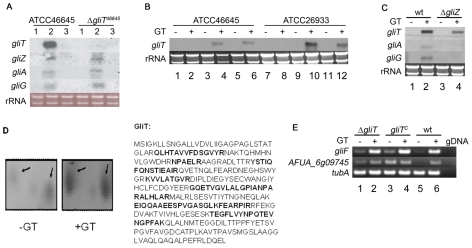

gliT expression.(A) Northern analysis of the induction of gliotoxin gene cluster expression in A. fumigatus ATCC46645 and ΔgliT. Lanes 1, 2 and 3 correspond to A. fumigatus RNA extracts from 21 h AMM, 21 h AMM shifted to gliotoxin (5 µg/ml) for 3 h and 24 h AMM, respectively. (B) Gliotoxin induction of gliT expression in A. fumigatus gliT
C strains. Lanes 1–6 and 7–12 contain RNA from strains in the ATCC46645 and ATCC26933 backgrounds, respectively. Lanes 1 and 7: A. fumigatus ΔgliT 24 h AMM; Lanes 2 and 8: A. fumigatus ΔgliT 21 h AMM+3 h gliotoxin (5 µg/ml); Lane 3 and 9: A. fumigatus gliT
C 24 h AMM; Lanes 4 and 10: A. fumigatus gliT
C 21 h AMM+3 h gliotoxin (5 µg/ml); Lanes 5 and 11: A. fumigatus wt 24 h AMM; Lane 6 and 12: A. fumigatus wt 21 h AMM+3 h gliotoxin (5 µg/ml). (C) Expression of gliT in ΔgliZ following exposure to gliotoxin. Cultures of A. fumigatus ATCC46645 (lanes 1 and 2) and ΔgliZ (lanes 3 and 4) were grown for 24 h in AMM (Lane 1 and 3) or pulsed with gliotoxin (5 µg/ml) after 21 h and cultured for a further 3 h (Lane 2 and 4). Although gliotoxin induced expression of gliA and gliG in wild-type, neither gliA or gliG are expressed in ΔgliZ. All Northern analyses were performed with 10 µg of total RNA isolated from strains grown in AMM for 24 h with or without gliotoxin. (D) A. fumigatus GliT expression and identification. Quantitative 2D-PAGE analysis confirmed increased expression (threefold) of GliT following exogenous gliotoxin (GT) addition to A. fumigatus cultures (GliT appears to exist as two isoforms of different pI (5.5–5.6) and Mr). Peptides identified by MALDI-ToF mass spectrometry are highlighted in bold (33% sequence coverage) and mass spectrum is given in Figure S3. (E) Semi-quantitative RT-PCR of gliT adjacent genes in A. fumigatus wild-type (wt) (ATCC26933) and isogenic mutant strains. Expression of gliF and AFUA_6g09745 (gliH) was examined. As a control tubA expression was monitored. As a negative control genomic DNA (gDNA) was used as template. Lane 1: A. fumigatus ΔgliT
26933 24 h AMM. Lane 2: A. fumigatus ΔgliT
26933 21 h AMM+3 h gliotoxin (5 µg/ml). Lane 3: A. fumigatus gliT
C 24 h AMM. Lane 4: A. fumigatus gliT
C 21 h AMM+3 h gliotoxin (5 µg/ml). Lane 5: A. fumigatus wt 24 h AMM. Lane 6: A. fumigatus wt 21 h AMM+3 h gliotoxin (5 µg/ml).